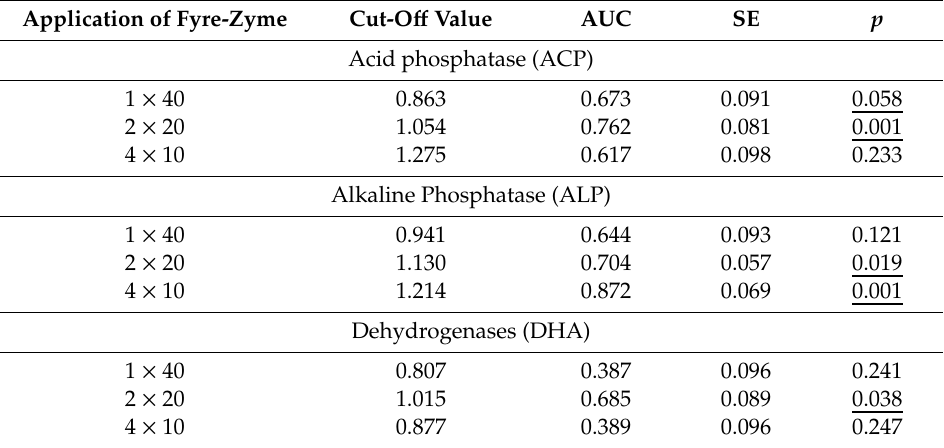
Table 8. ROC values of indices of Fyre-Zyme reagent impact on soil enzyme antivities. Application of